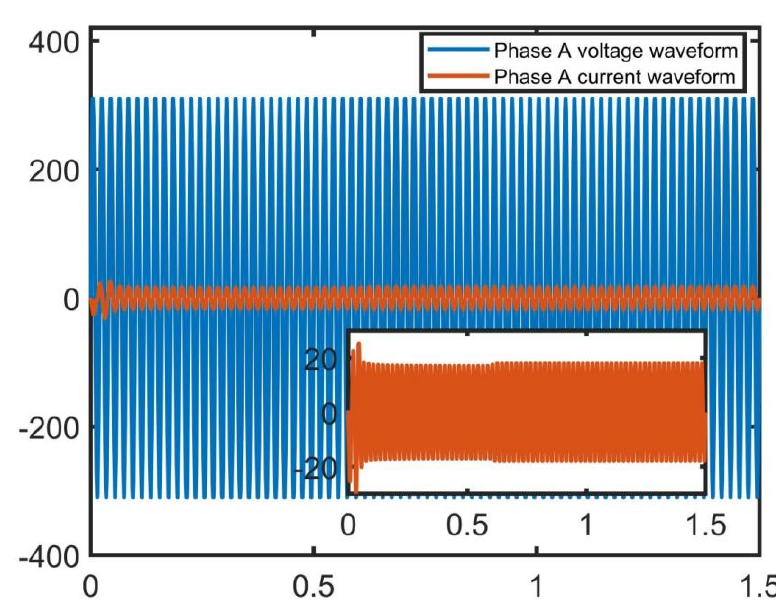
Figure 9. Light intensity.